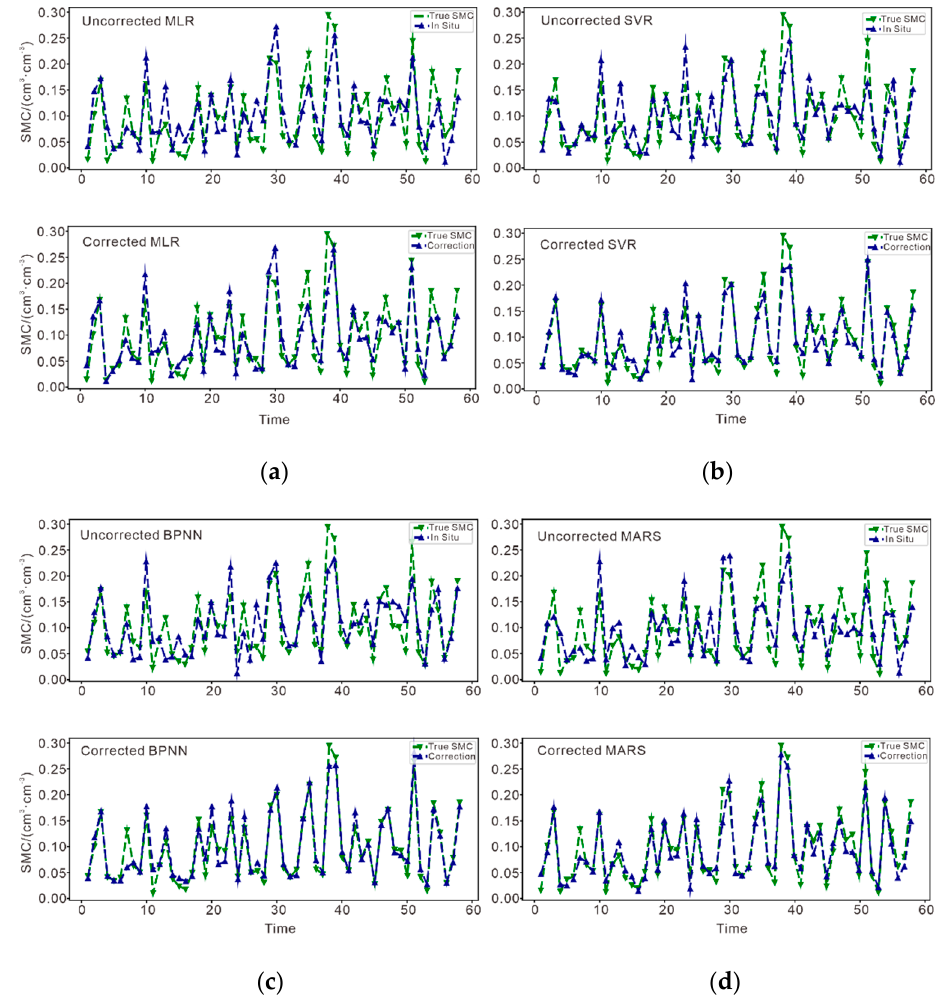
Figure 7. ( a ) MLR invert the soil moisture comparison map for the two conditions of uncorrected phase and corrected phase. ( b ) SVR invert the soil moisture comparison map for the two conditions of uncorrected phase and corrected phase. ( c ) BPNN invert the soil moisture comparison map for the two conditions of uncorrected phase and corrected phase. ( d ) MARS invert the soil moisture comparison map for the two conditions of uncorrected phase and corrected phase.